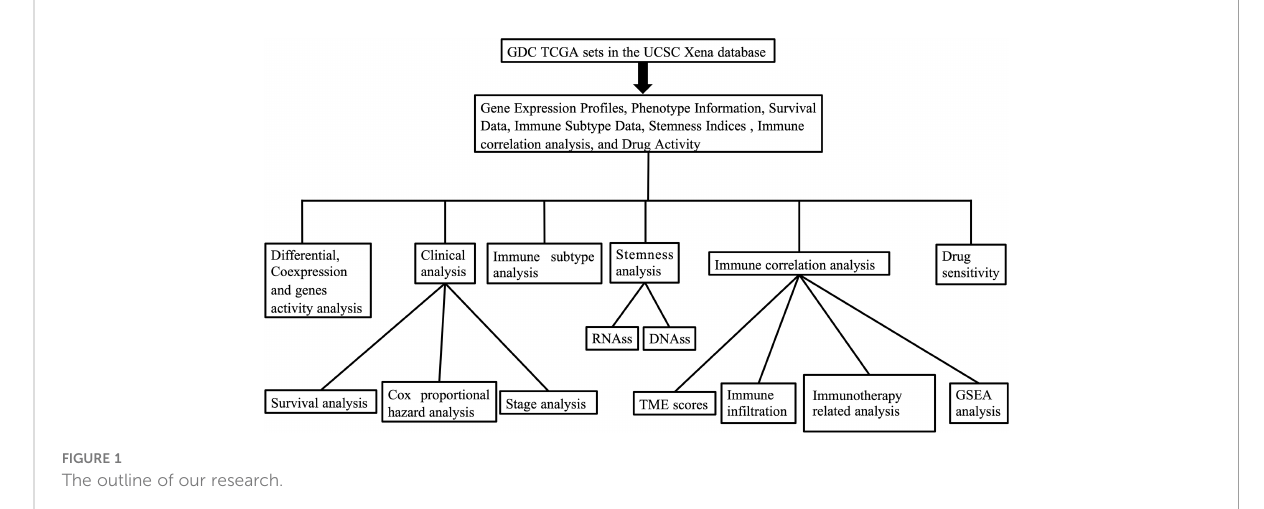
FIGURE 1 The outline of our research.